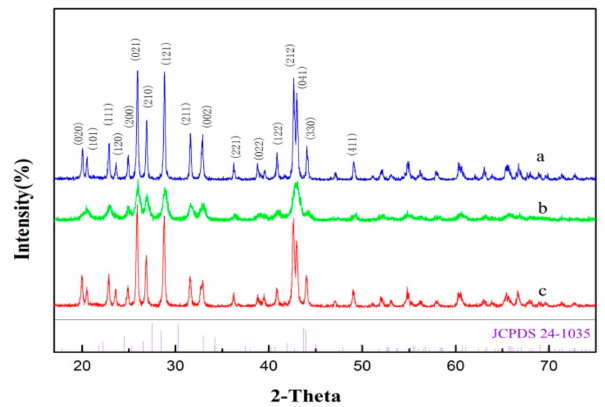
Figure 2. X-ray powder diffraction (XRD) pattern of BaSO 4 : ( a ) in the presence of BaCl 2 and Na 2 SO 4 , ( b ) in the presence of BaCl 2 , Na 2 SO 4 , and EDTA, and ( c ) in the presence of BaCl 2 and Na 2 SO 4